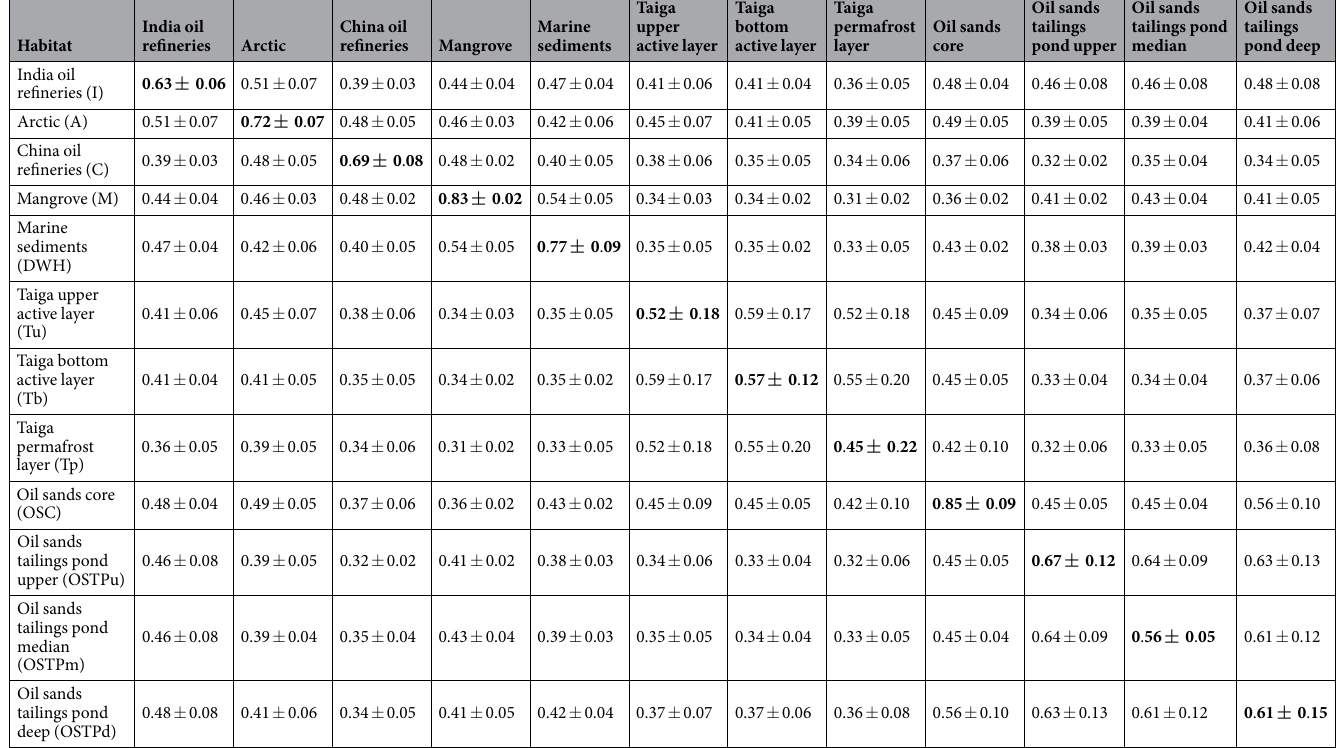
Table 2. Similarities of bacterial community structure within a habitat and between pairs of habitats expressed as Bray-Curtis distances.